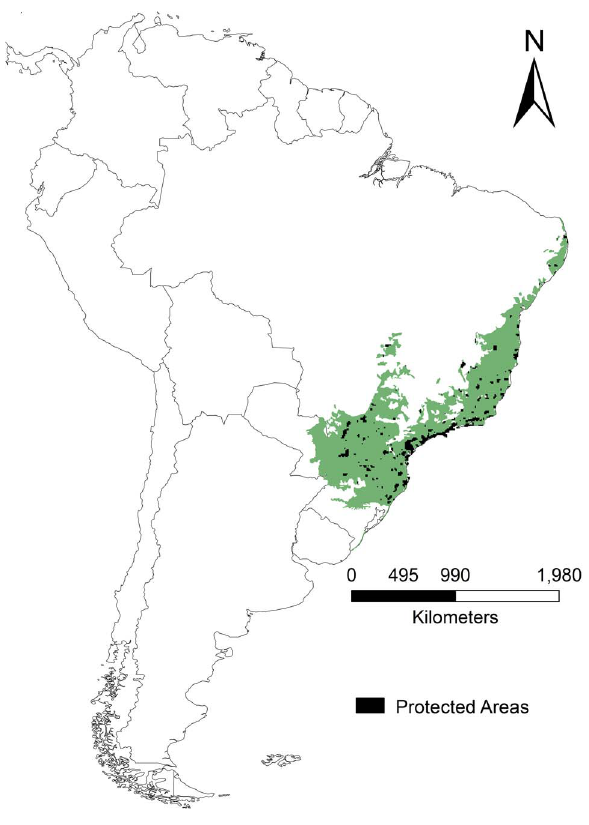
Figure 1. Original extent of the Atlantic Forest Biodiversity Hotspot in